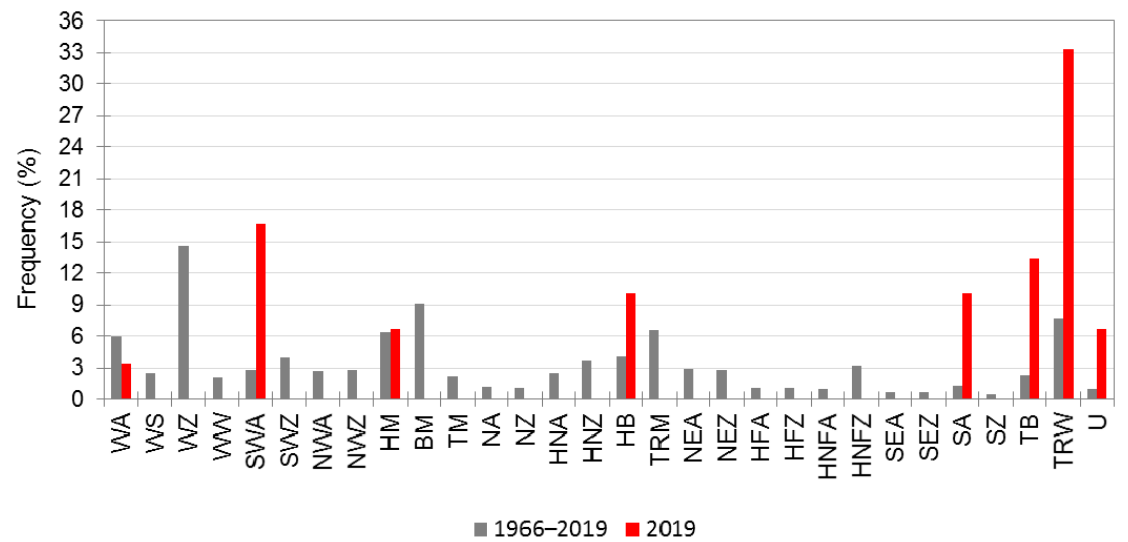
Figure 10. Frequency of occurrence of individual GWL circulation types in June in the years 1966–2019 and 2019.